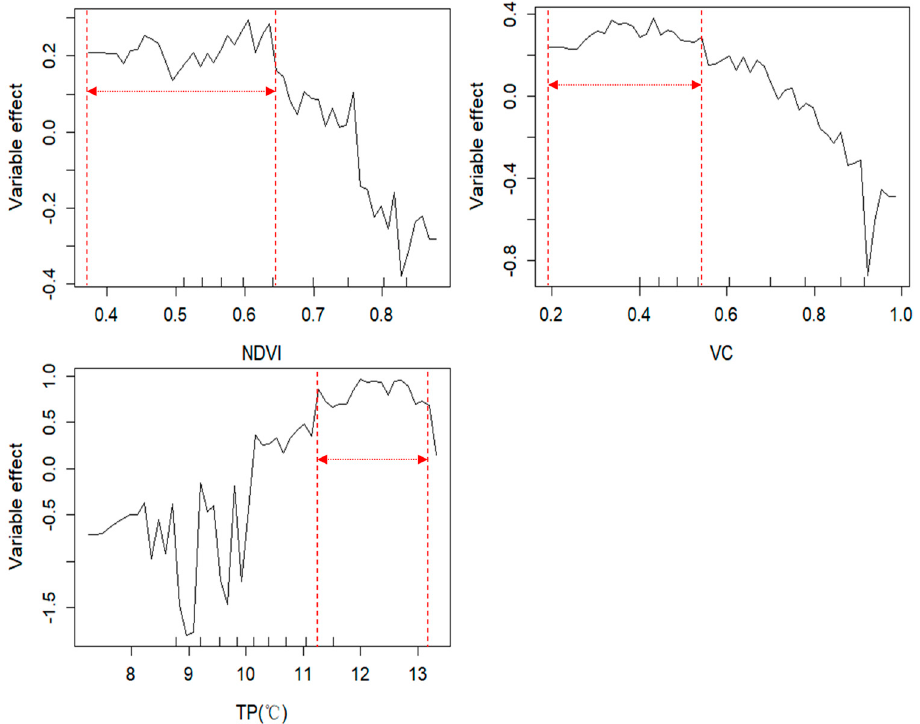
Figure 9. Influences of NDVI, VC, and TP on advanced LES status (high level and medium − high level) based on the random forest model. LES represents land ecological security; NDVI represents normalized differential vegetation index; VC represents vegetation coverage; TP represents land surface temperature. The value between the red dotted lines represents the optimal threshold range of NDVI, VC, and TP required by the advanced LES status.